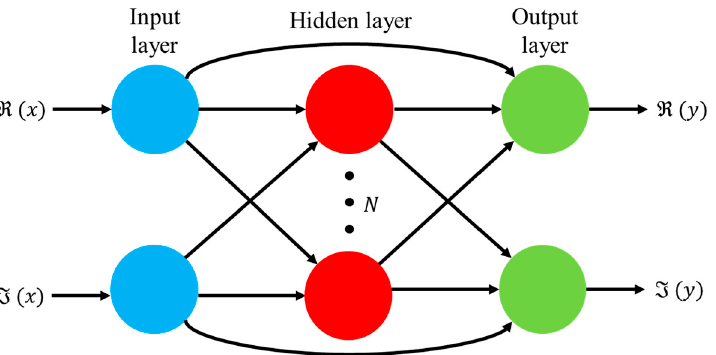
Figure 4. Schematic showing block diagram of NN structure used in this article, feedforward fully connected (FC) NN. FC-NN contained N hidden layers and K neurons per hidden